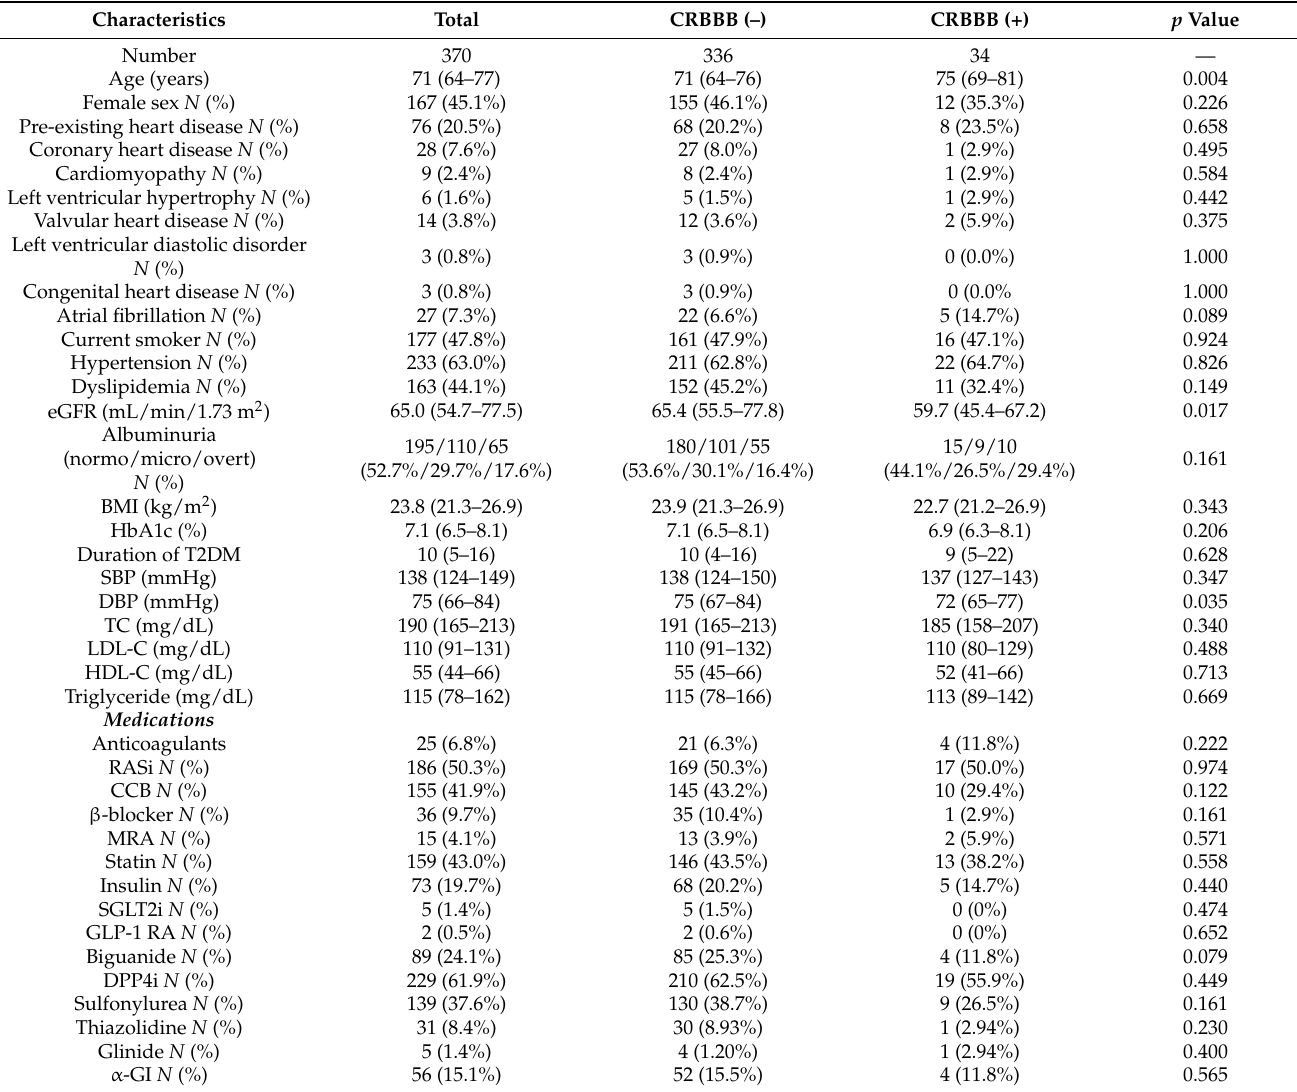
Table 1. Characteristics of T2DM patients by